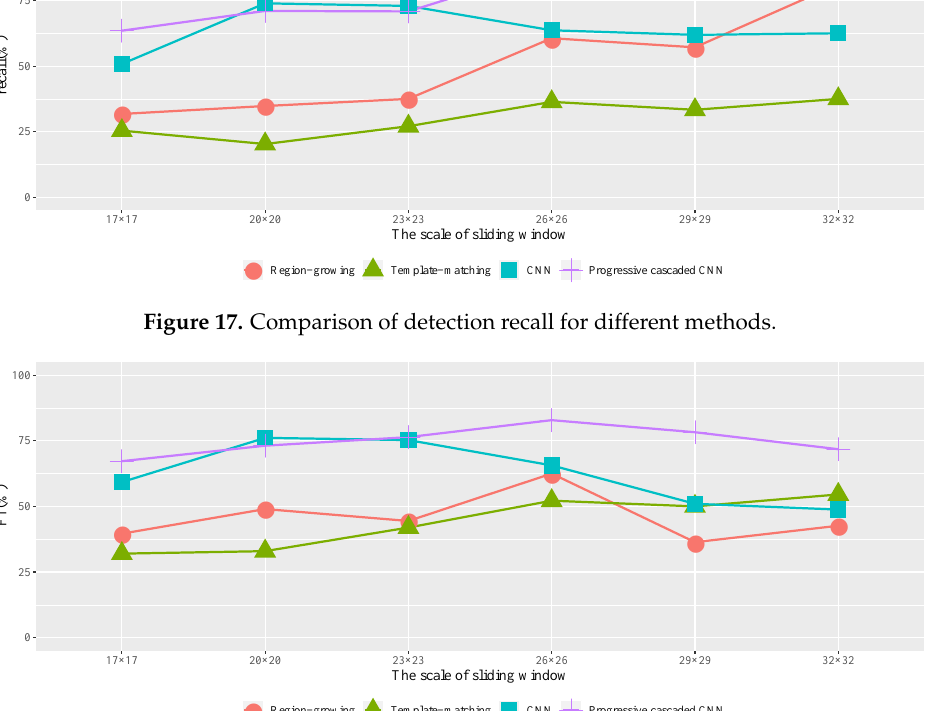
Figure 18. Comparison of F1 measurements for different